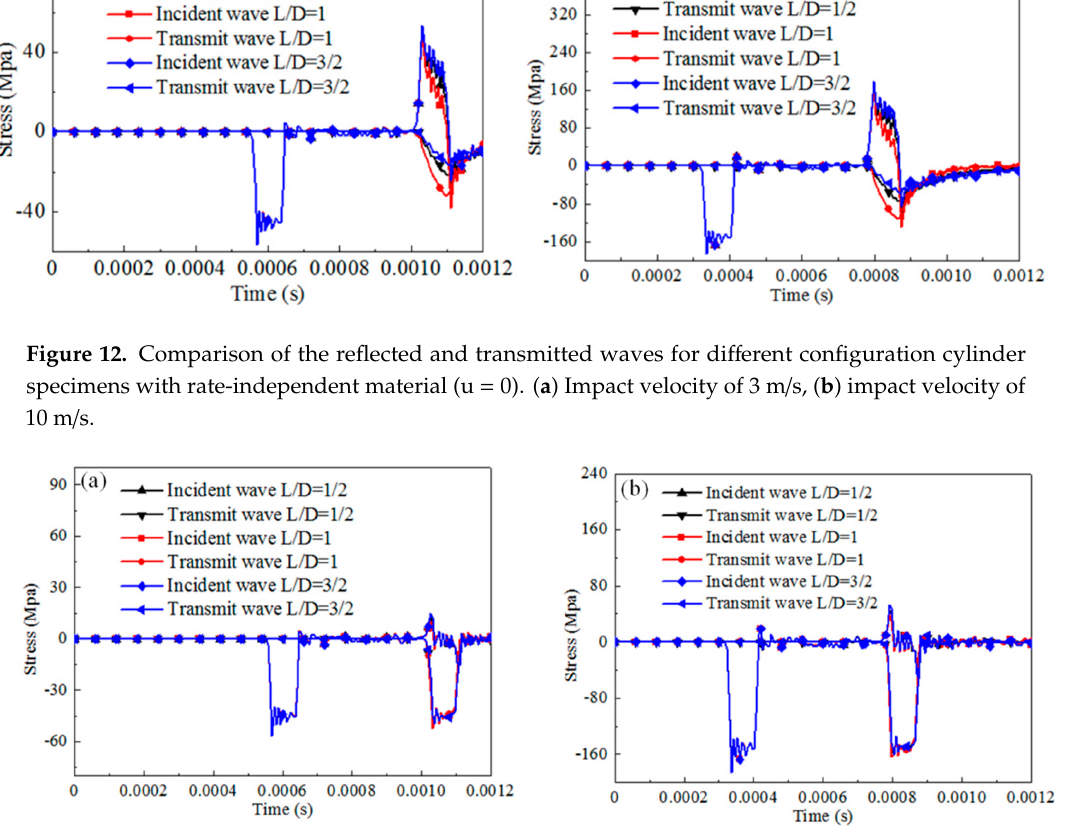
Figure 13. Comparison of the reflected and transmitted waves for different configurations of the cylinder specimen with rate-dependent elastic-plastic material (u = 0). ( a ) Impact velocity of 3 m/s, ( b ) impact velocity of 10 m/s.